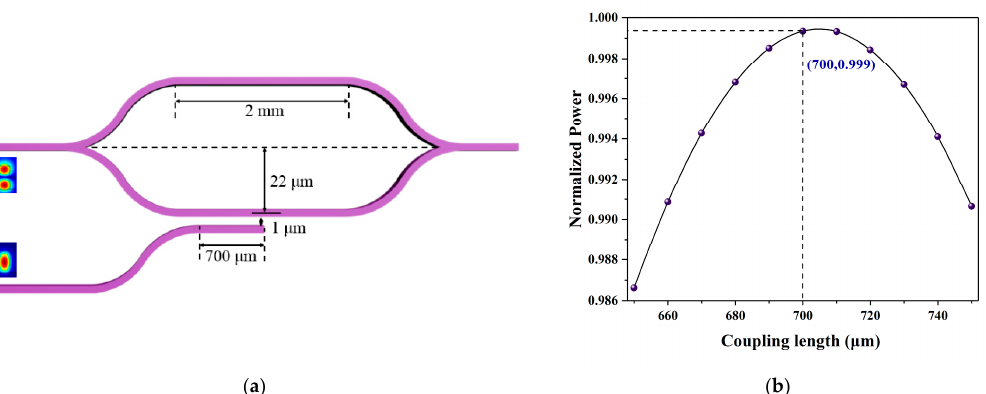
Figure 5. ( a ) Schematic diagram of coupler. ( b ) The normalized power as a function of the coupling length.